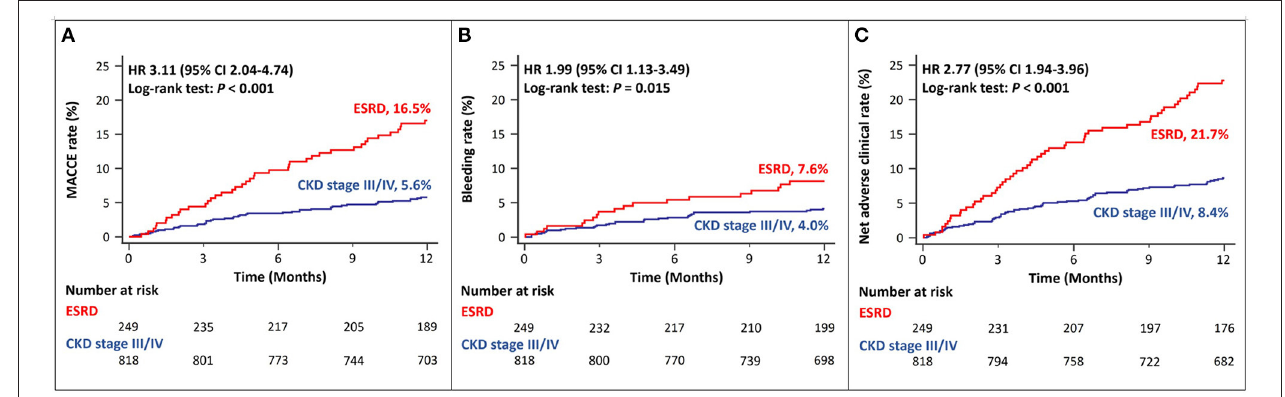
FIGURE 2 | Twelve-month cumulative incidence of major adverse cardiac and cerebrovascular events (A) , bleeding (B) , or net adverse clinical (C) events, compared between CKD stage III/IV and ESRD. MACCE, Major Adverse Cardiac and Cerebrovascular Event; CKD, Chronic Kidney Disease; ESRD, End Stage Renal Disease.